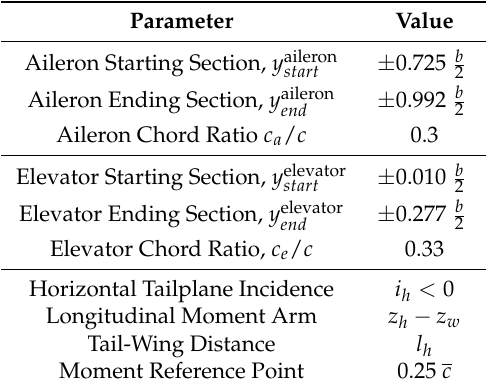
Figure 4. Distances between horizontal tailplane and wing. Table 2. Clean surfaces: geometrical